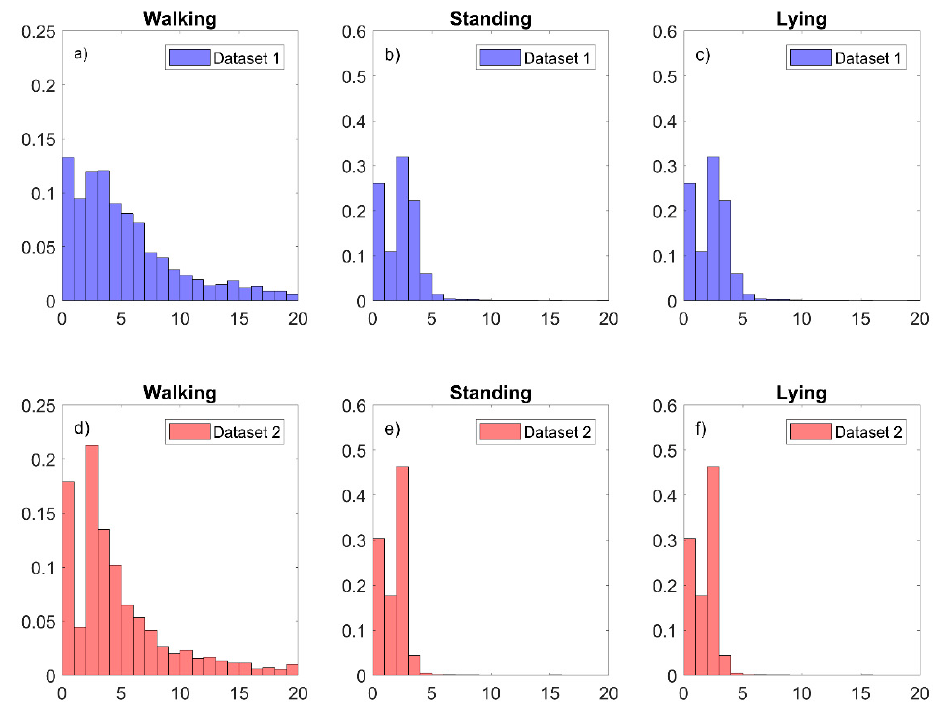
Figure 8. Distribution of the MeanAMag for our previously collected dataset [8] (dataset 1) and for this study (dataset 2). The plot shows the distribution change between the two studies for the three different behaviours. ( a – c ) show the distributions of the MeanAMag for walking, standing and lying using collected dataset [8], ( d – f ) show the distribution of the MeanAMag for this study.